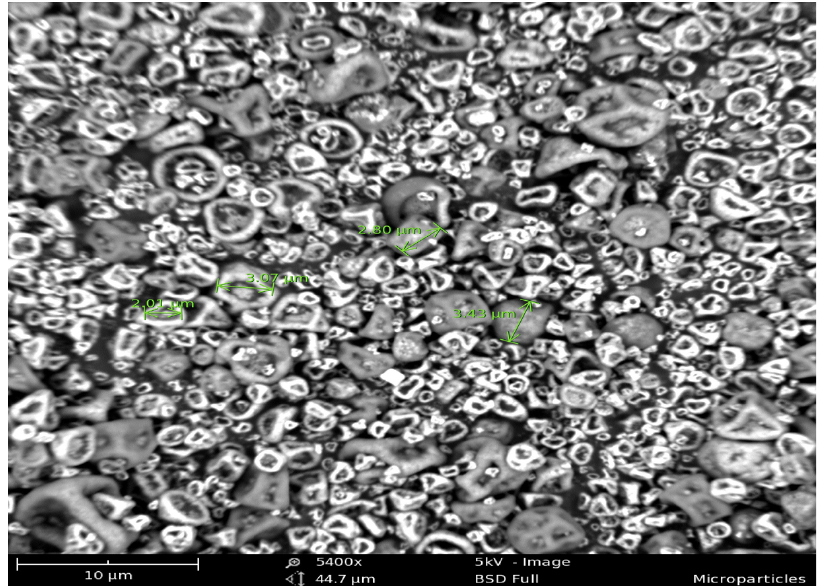
Figure 1. Scanning electron micrograph of polymeric microparticles. SEM images were captured using Phenom Desktop SEM ® by placing the microparticles on a conductive carbon tape and observed at 4100 × 5 kV. Microparticles exhibited an irregular shape with a particle size range of 1 to 4 µm.